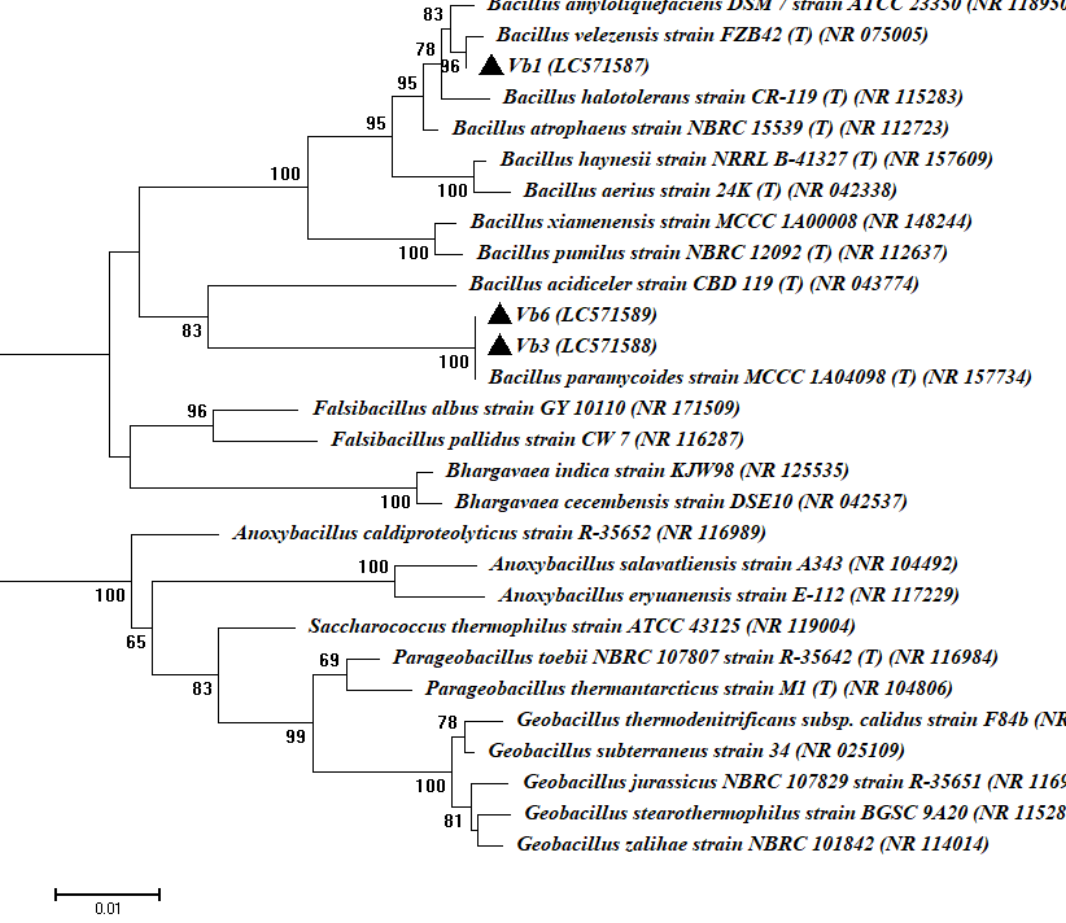
Table 2: Characterization of selected rhizosphere bacterial strains Vb1, Vb3, and Vb6 as plant growth-promoting. Test